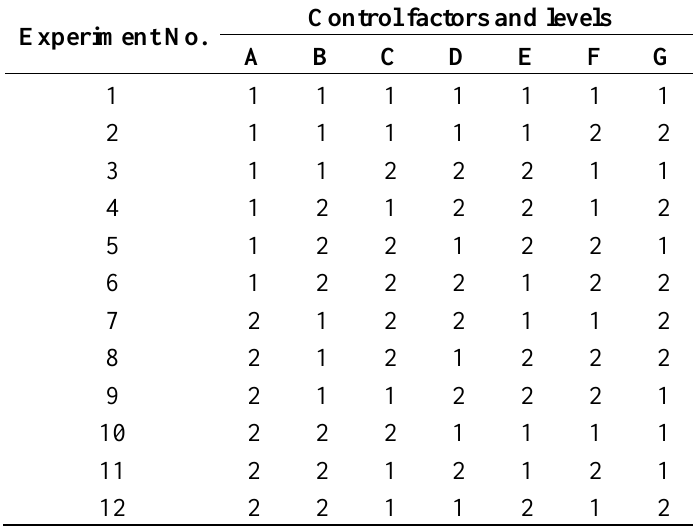
Table 4. L (2 7 ) Orthogonal 12